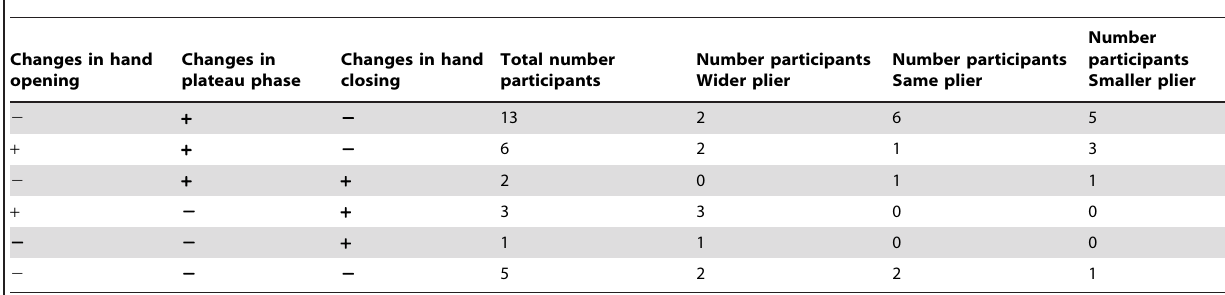
Table 2. Assessment of changes in duration of hand opening, plateau phase and/or hand closing over learning.